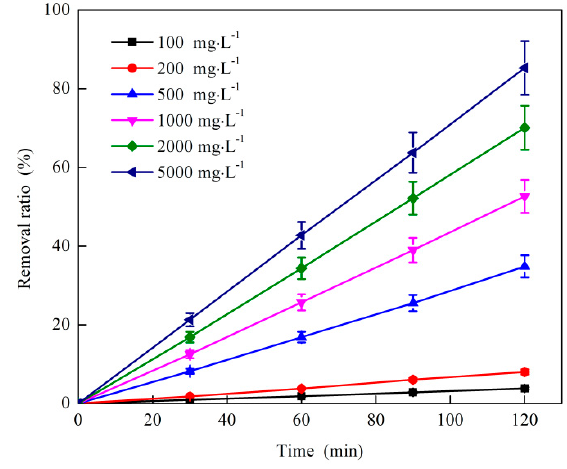
Figure 4. E ff ect of O 3 dosage on coking wastewater treatment by O 3 catalytic oxidation. Figure 4. Effect of O 3 dosage on coking wastewater treatment by O 3 catalytic oxidation.